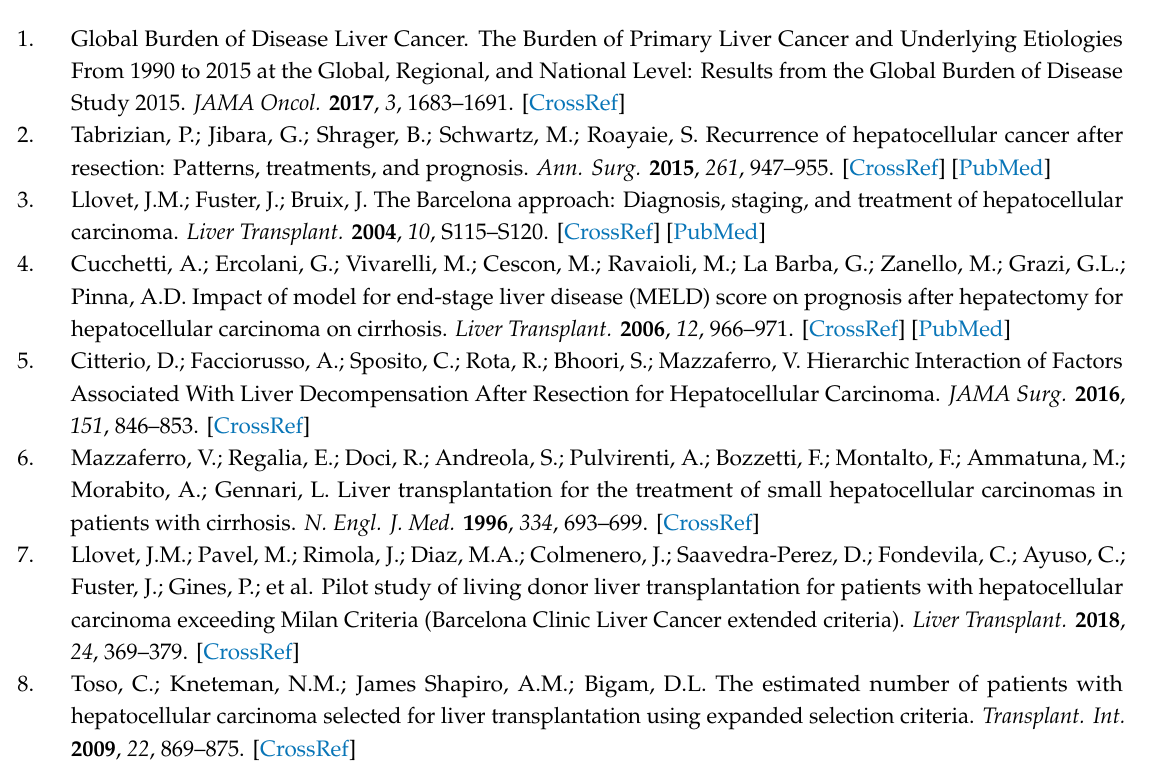
Figure S1: Analysis of downstream e ff ectors of IL-10 pathway using The Cancer Genome Atlas (TCGA) data, Table S1: Comparison of preoperative plasma versus serum biomarkers in patients who underwent liver resection, Table S2: Analysis of clinical parameters and circulating biomarker of interest stratified by Milan criteria in HCC patients who underwent liver